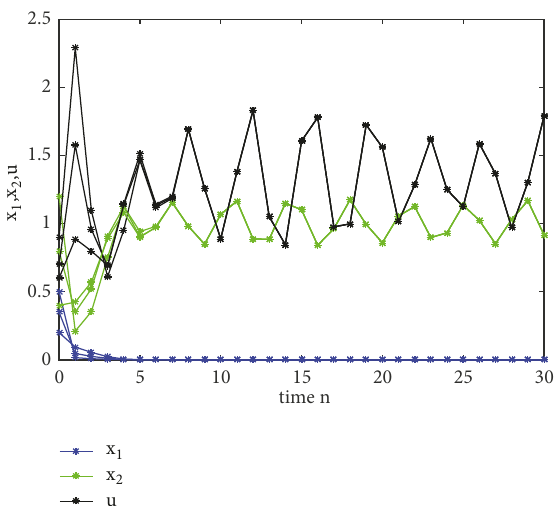
Figure 2: Dynamic behaviors of the solutions (𝑥 1 (𝑛),𝑥 2 (𝑛),𝑢(𝑛)) of system (106) with the initial conditions (𝑥 1 (𝜃),𝑥 2 (𝜃),𝑢(𝜃)) = (0.2, 0.4, 0.6),(0.35, 0.8, 0.7),(0.5, 0.1.2, 0.9) for 𝜃 = ⋅⋅ ⋅ ,−𝑛, −𝑛 + 1, ⋅ ⋅ ⋅ ,−1, 0 ,